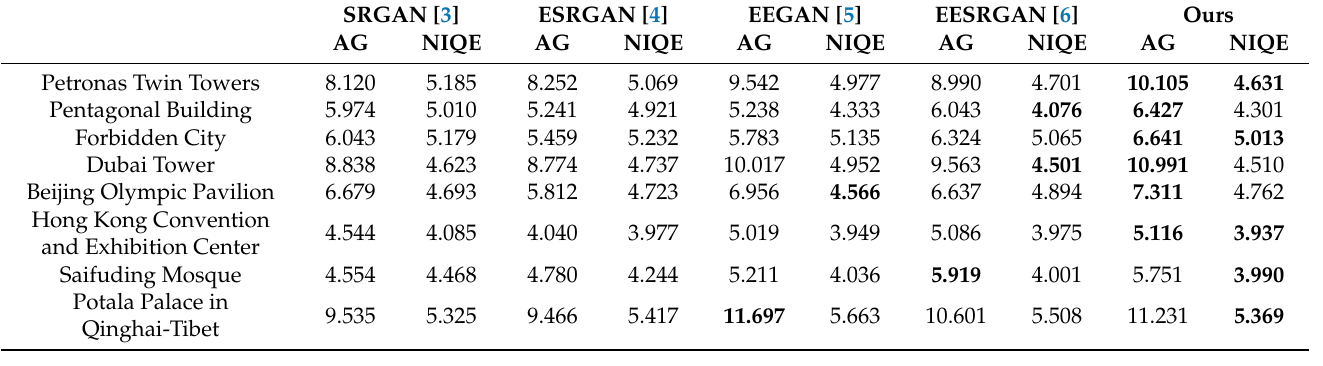
Table 8. SR result performance comparison in the SpaceWill dataset, where the best results are shown in boldface.